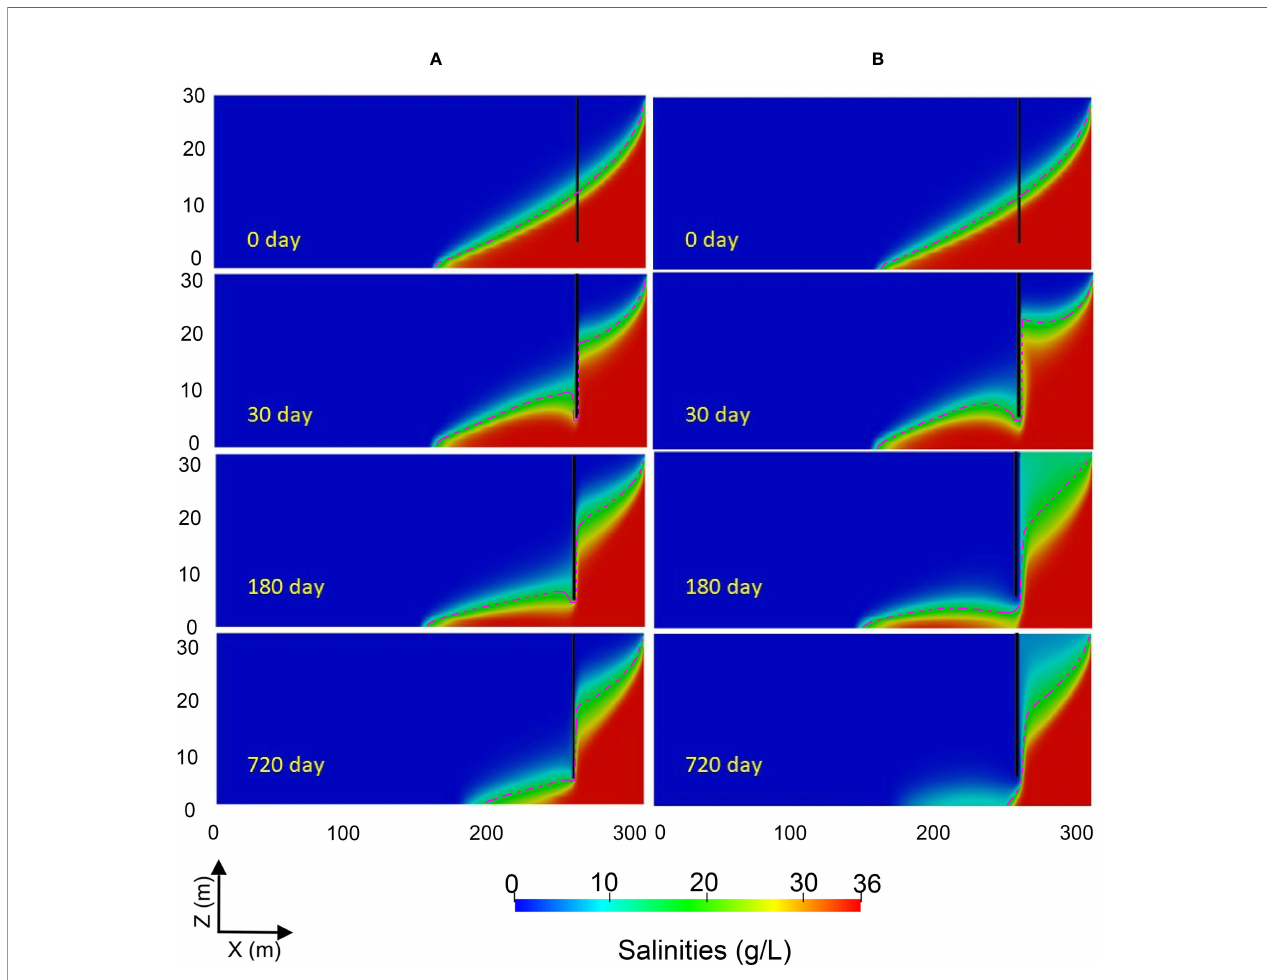
FIGURE 11 | Transient distributions of residual saltwater after the construction of a 25 m-depth cut-off wall with hydraulic conductivity of 4×10 -6 m/s (A) and 10 -7 m/s (B) at 50 m from the sea boundary at 0, 30, 180 and 720 day. The vertical black lines represent the cut-off walls, and the red dotted lines are the isolines of 50% salinity of the saltwater.